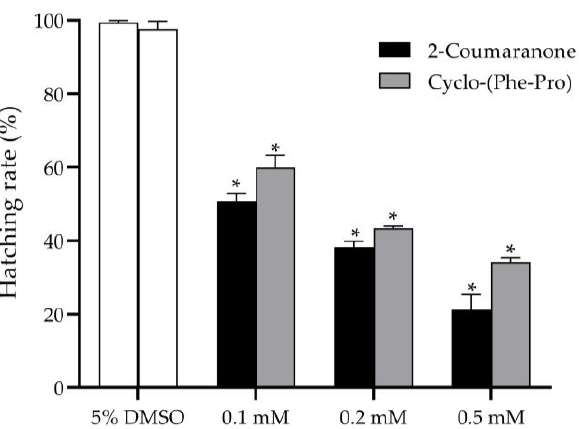
Figure 5. Effects of nematicidal compounds on cumulative hatching rates after 48 h. Mean values of four replications were plotted with SD. The asterisk denoted significant difference at p < 0.05 compared to controls according to Student’s t -test.